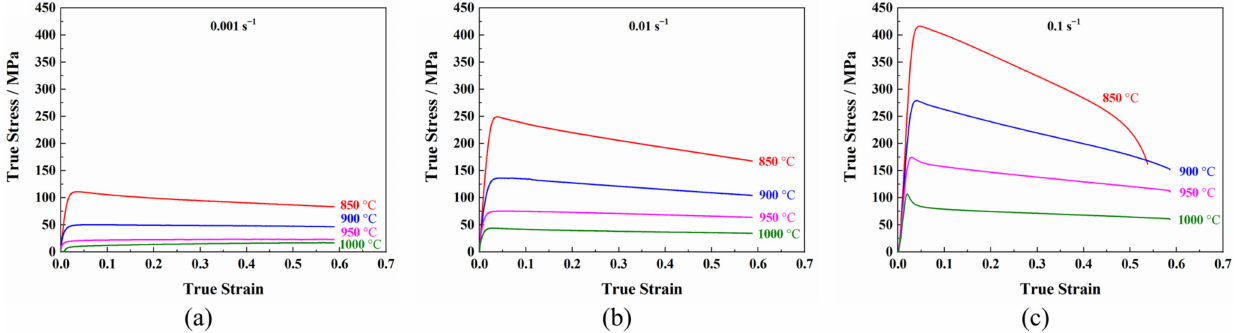
Figure 3. The flow behavior of the TC31 titanium alloy at different strain rates: ( a ) 0.001 s − 1 ; ( b ) 0.01 s − 1 ; ( c ) 0.1 s − 1